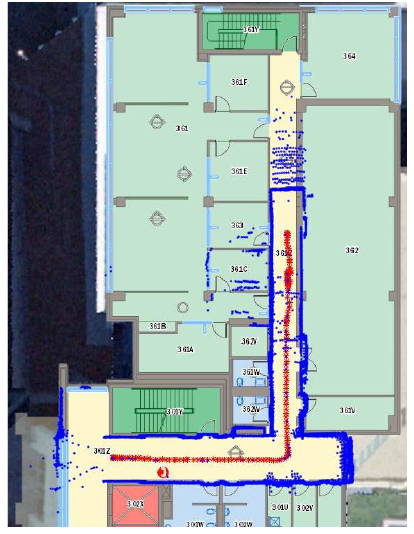
Figure 7. Mapping and position results of the Hector SLAM. Figure 8 depicts the mapping and position results for the RKF algorithm. The blue points represent the constructed map, while the red asterisks represent the vehicle’s trajectory. Although